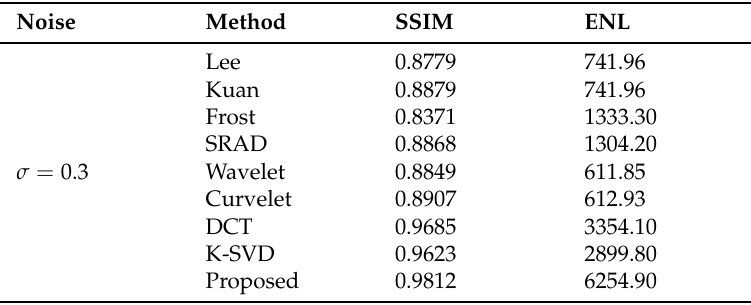
Table 1. The objective evaluation values of denoising results.